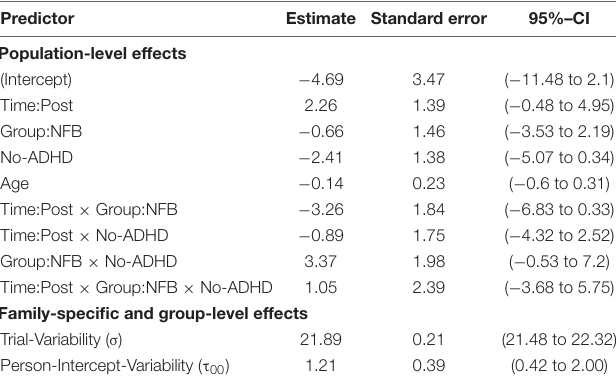
TABLE 2 | Summary of the results obtained by the binary moderator model of CNV amplitude at channel FCz. Predictor Estimate Standard error